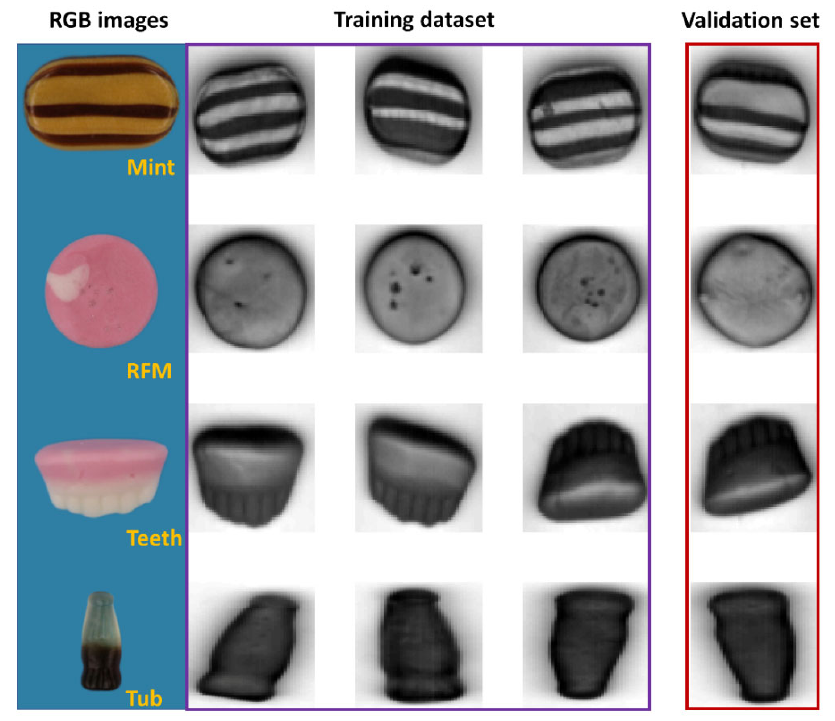
Figure 1. The RGB images of sweet samples and mean images at the spectral